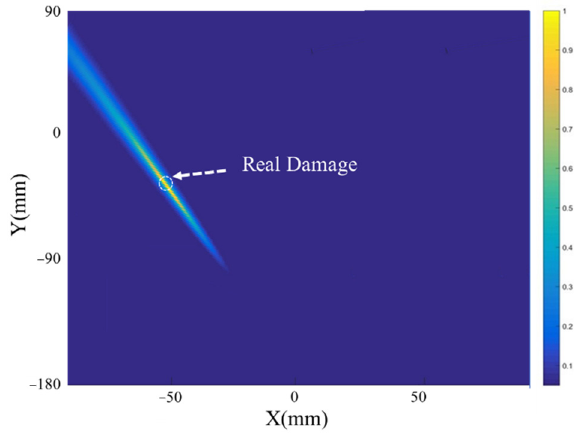
Figure 20. Normalize eigenvalue of single ‐ damage case.